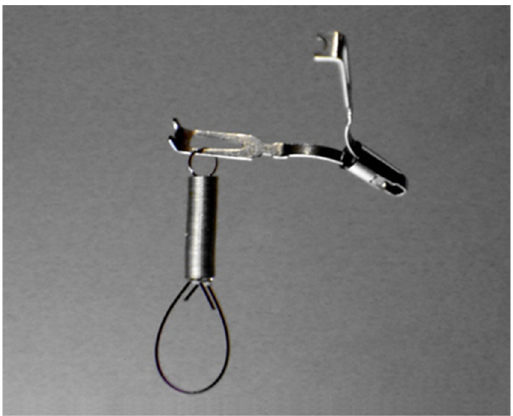
Figure 1. The external appearance of an S-O clip. The S-O clip comprised a metal clip (ZEOCLIP; Zeon Medical Co., Ltd.) and a 5 mm long spring. A nylon loop is attached to the other side of the spring and fixed to the colon wall using a second clip. The S-O clip can be passed through the channel of a conventional endoscope.